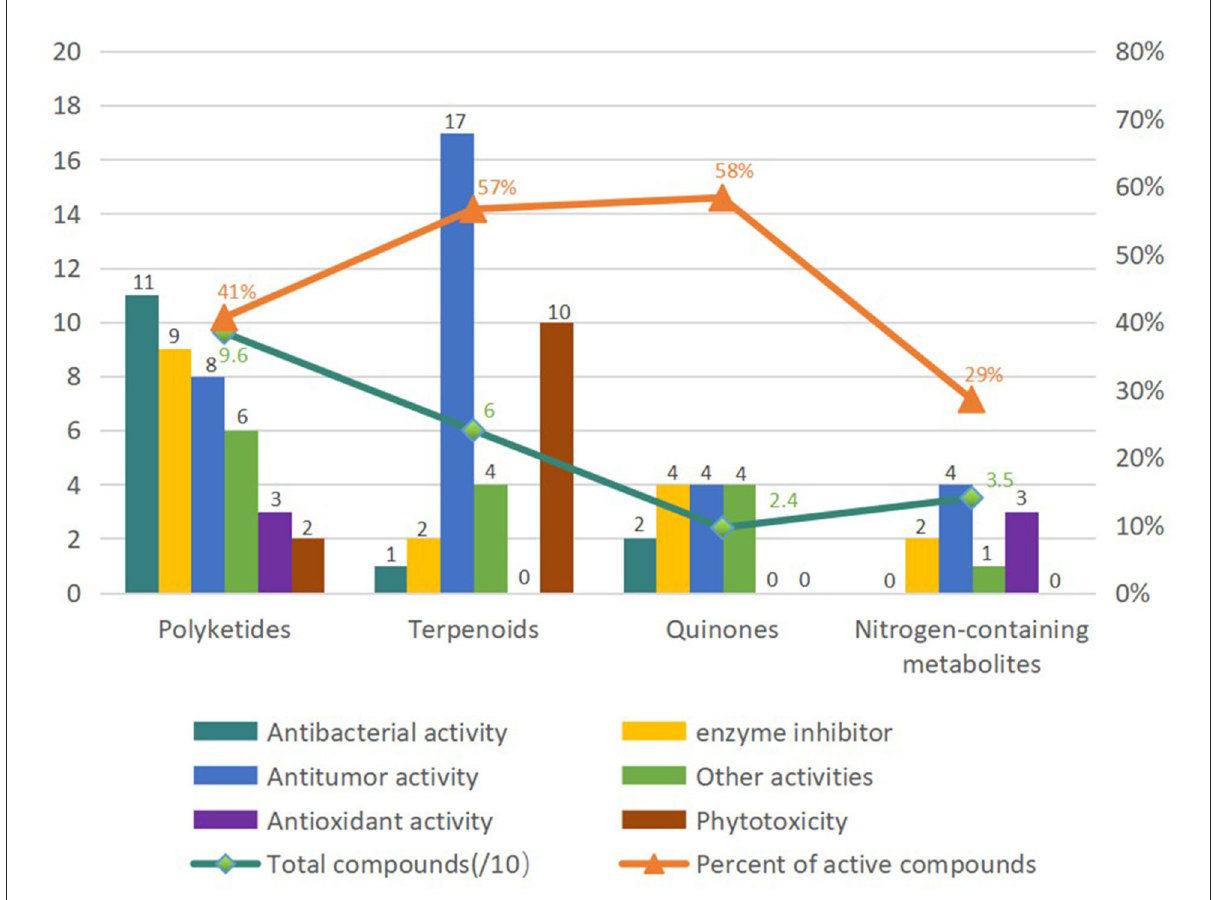
FIGURE17 Classification of diverse chemicals of Alternaria fungi based on the pharmacological